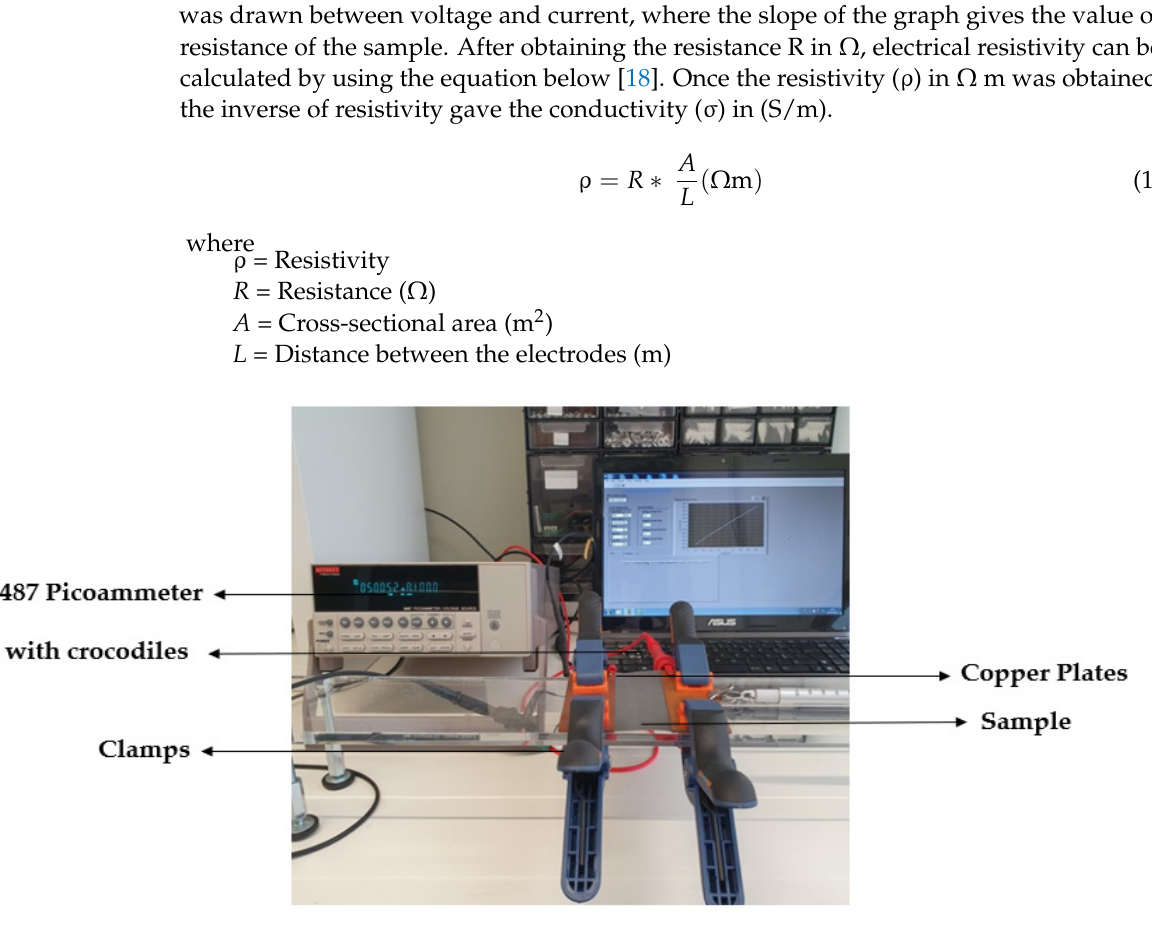
Figure 3. Setup for measuring electrical resistance.